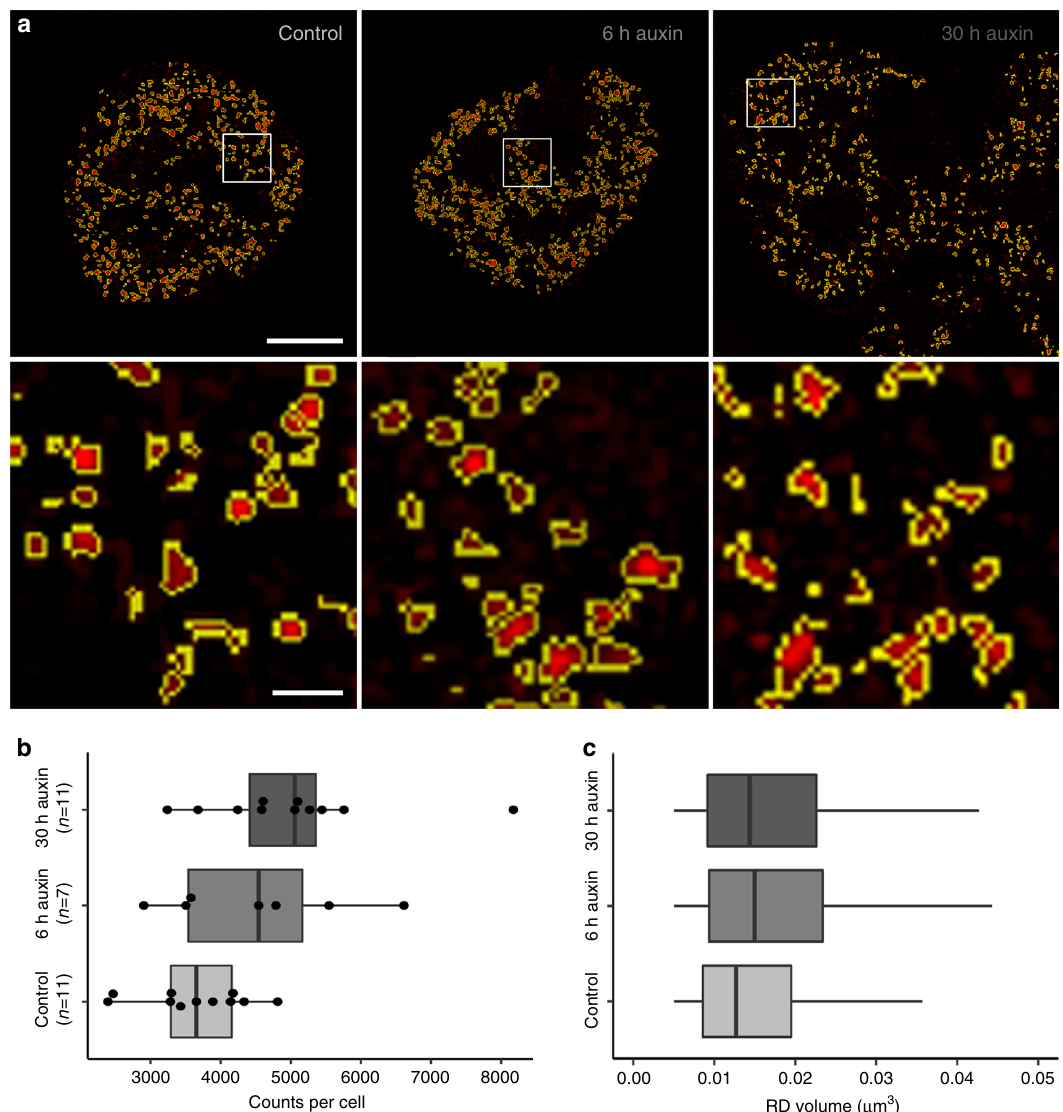
Fig. 8 Segmentation of individual replication domains (RDs), pulse-labeled in early S-phase, indicate structural changes after cohesin depletion. a SIM nuclear mid-sections of nuclei with typical early S-phase patterns of replication domains (RDs) from a control culture (left), a 6 h auxin-treated culture (middle), both fi xed 6 h after RL, and a multilobulated nucleus (right) obtained after 30 h auxin treatment (compare Fig. 6a – d). Enlargements of boxed areas show individual, segmented RDs displayed in red with segmented borders lined in yellow. Scale bar: 4 µ m, 0.5 µ m in inset magni fi cations. b Counts of segmented RDs plotted for control nuclei, cohesin depleted nuclei after 6 h auxin and MLN after 30 h auxin are presented as dots (control: n = 11, 6 h: n = 7, 30 h: n = 11 nuclei from two independent experiments). c Boxplots with corresponding volume distributions of segmented individual RDs (control: n = 39.334, 6 h: n = 31.467, 30 h: n = 55.153). The non-parametric two-sided Mann – Whitney test revealed signi fi cant differences of RD counts between control nuclei and MLN ( p = 0.012) and for RD volumes ( p < 0.0001 for control<-> 6 h auxin, control< − > 30 h auxin, and 6 h auxin< − > 30 h auxin). Volumes of RDs with dimensions below the resolution limit of 3D-SIM (~120 nm lateral/300 nm axial) show the same size and were excluded from consideration. Accordingly, the lower limits of volumes between control nuclei and cohesin depleted nuclei are identical in contrast to the differences of the upper volume limits. Data in b , c are represented as boxplots where the middle line indicates the median, the lower and upper hinges correspond to the 25 and 75% quartiles, the upper whisker extends to the largest value no further than 1.5 × IQR (inter-quartile range) from the hinge and the lower whisker extends to the smallest value from the hinge at most 1.5 × IQR. In b , all data points are plotted individually. Source data are provided as a Source Data fi